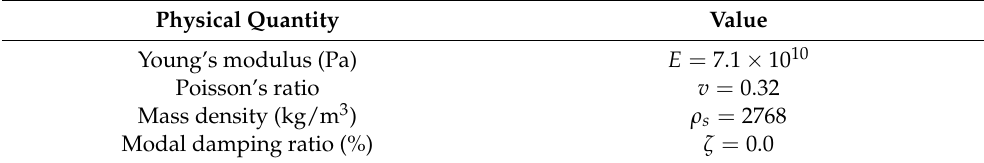
Table 1. Physical parameters of the square panel.